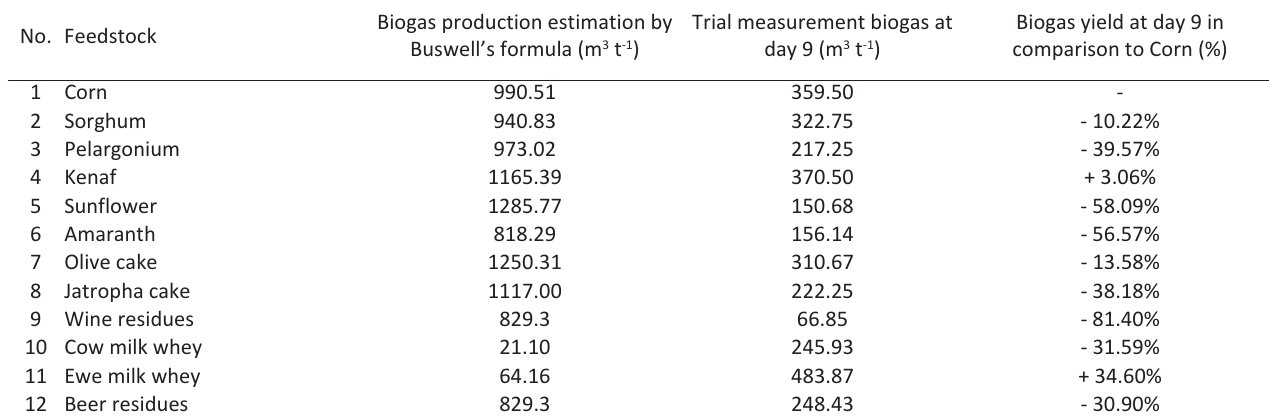
Table 4 - Buswell’s formula estimation, biogas experimental production and comparison with Corn’s biogas yield No. Feedstock